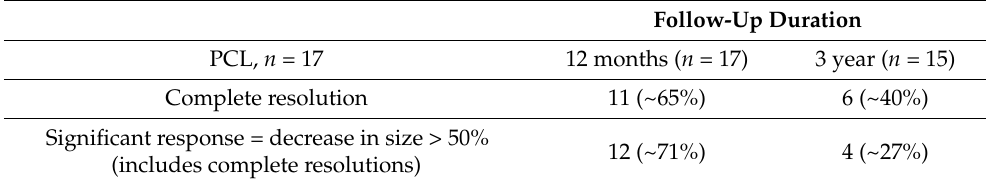
Table 2. Summary of response to EUS-RFA in PCLs (Barthet et al., 2021) [68]. Follow-Up Duration PCL, n = 17 12 months ( n = 17) 3 year ( n = 15) Complete